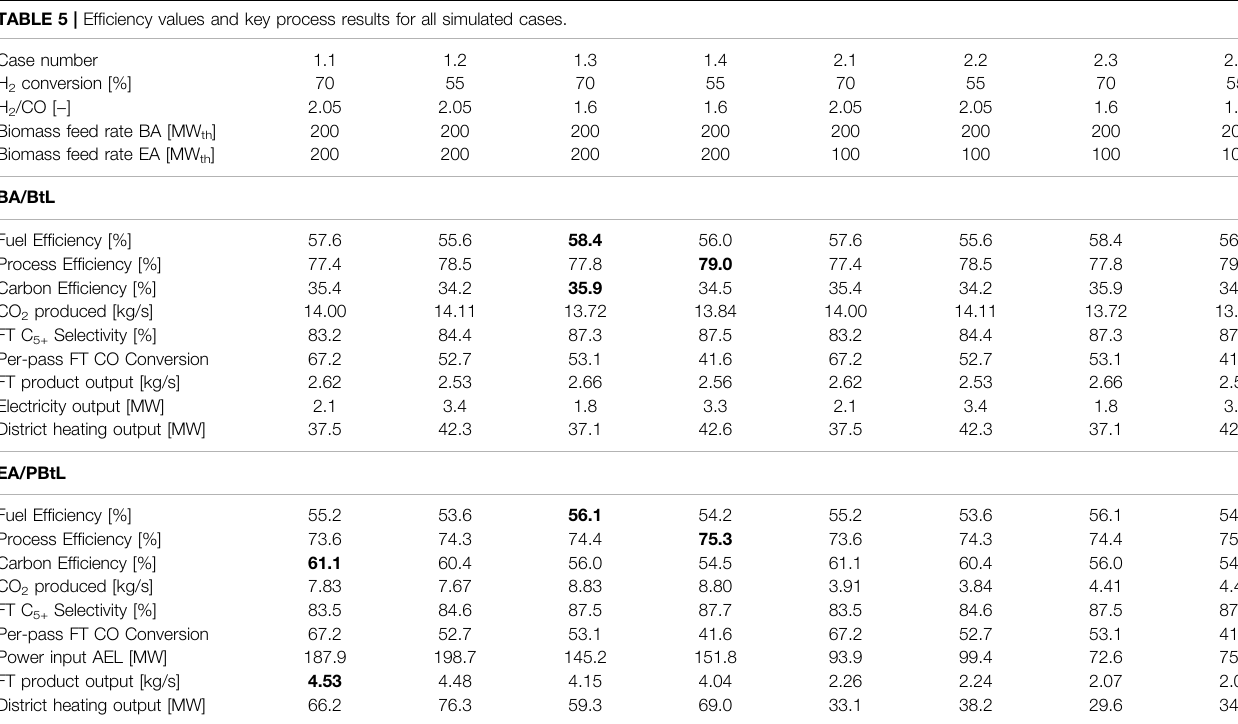
TABLE 5 | Ef fi ciency values and key process results for all simulated cases.